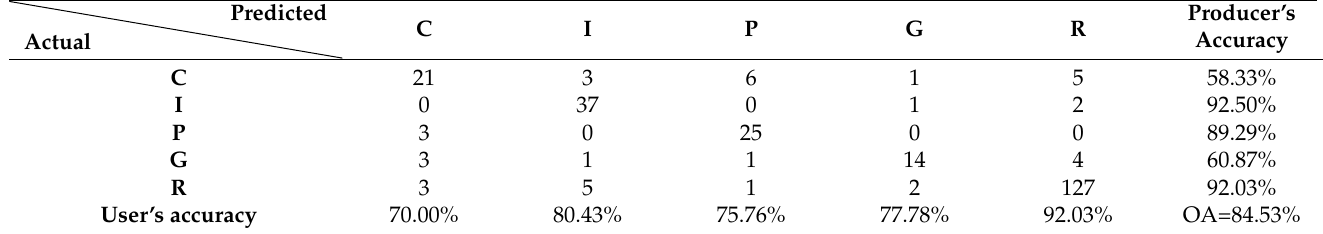
Figure 9. Misclassification map in Zhuhai using Graph SAGE model. Table 7. Confusion matrix for test dataset in Singapore using Graph SAGE